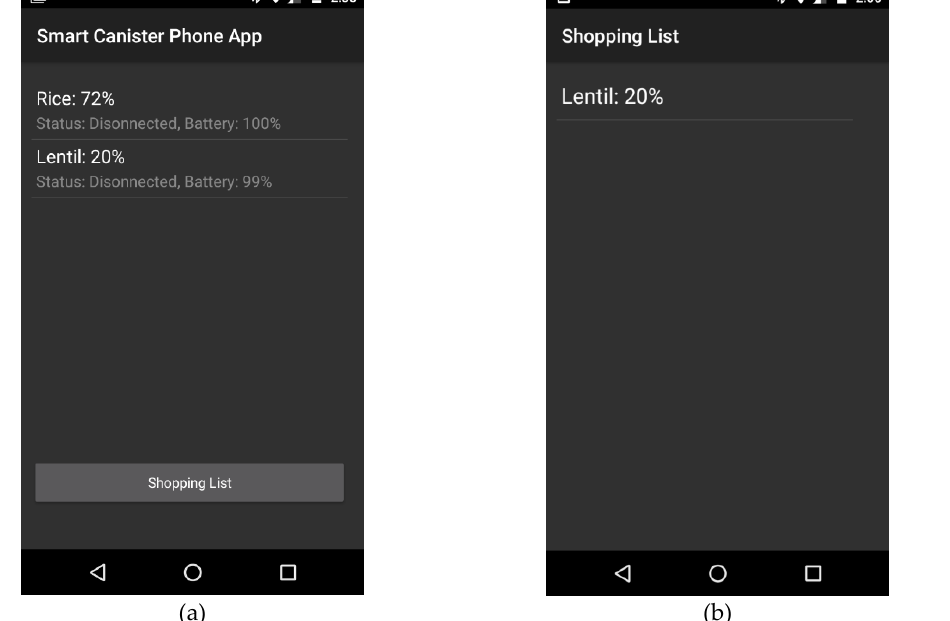
Figure 9. Screenshot of the smartphone app—( a ) front screen showing item names in the canisters, connection status, and battery levels; ( b ) shopping list showing the items that are below the threshold levels.